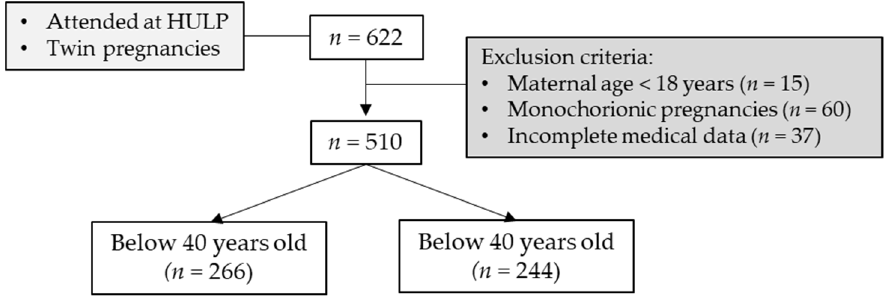
Figure 1. Flow chart of study participants. Sample size ( n ) is shown between brackets. HULP, Hospital Universitario La Paz.